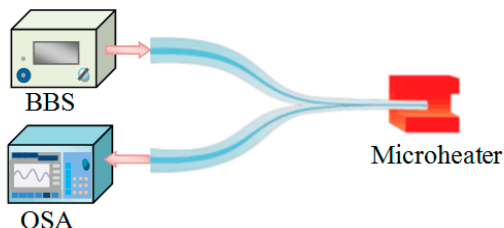
Figure 24. Schematic diagram of temperature measurement of an MFC tip. Table 2. Comparison of sensing parameters for different temperature sensors proposed previously.